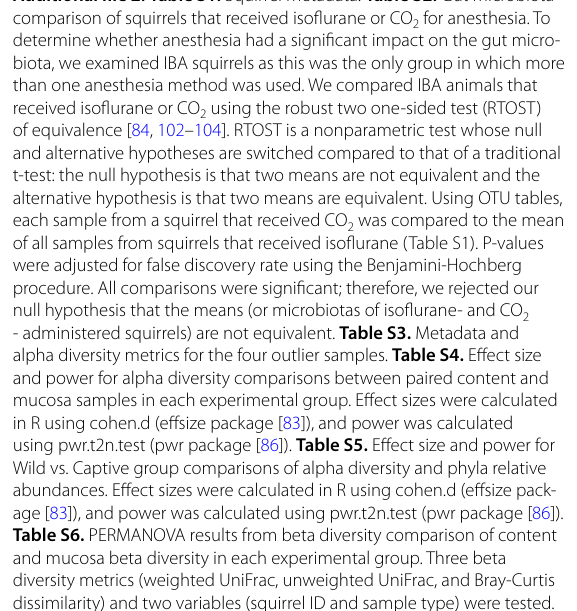
Table S6. PERMANOVA results from beta diversity comparison of content and mucosa beta diversity in each experimental group. Three